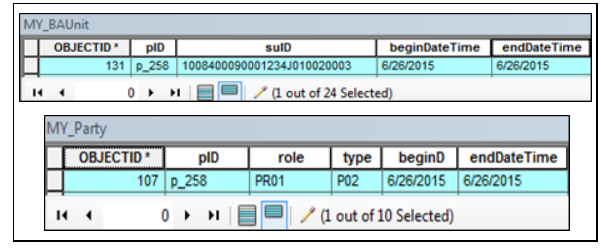
Figure 4. The result after MY_BAUnit table is related